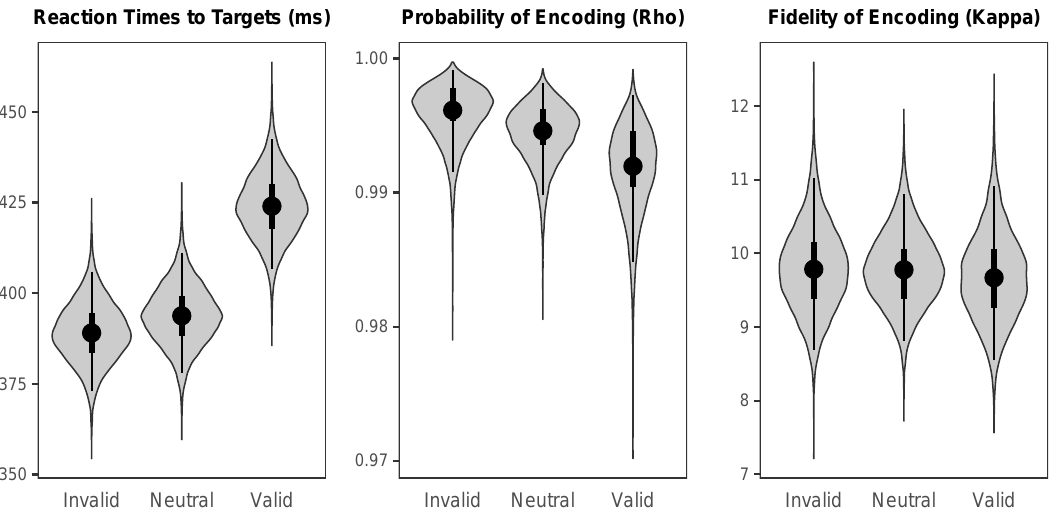
Figure 8. The probability distributions for the population means of the parameters of interest for each cueing condition at the long (800 ms)